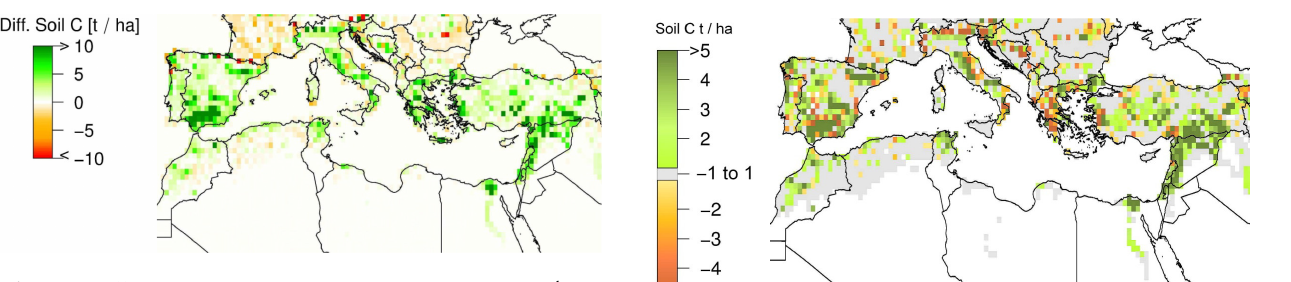
Figure 5. Difference in LPJmL-simulated soil organic carbon (aver- age 2000–2009) before and after the implementation of agricultural trees described in this study. Negative (positive) values indicate that the development decreased (increased) soil organic content.